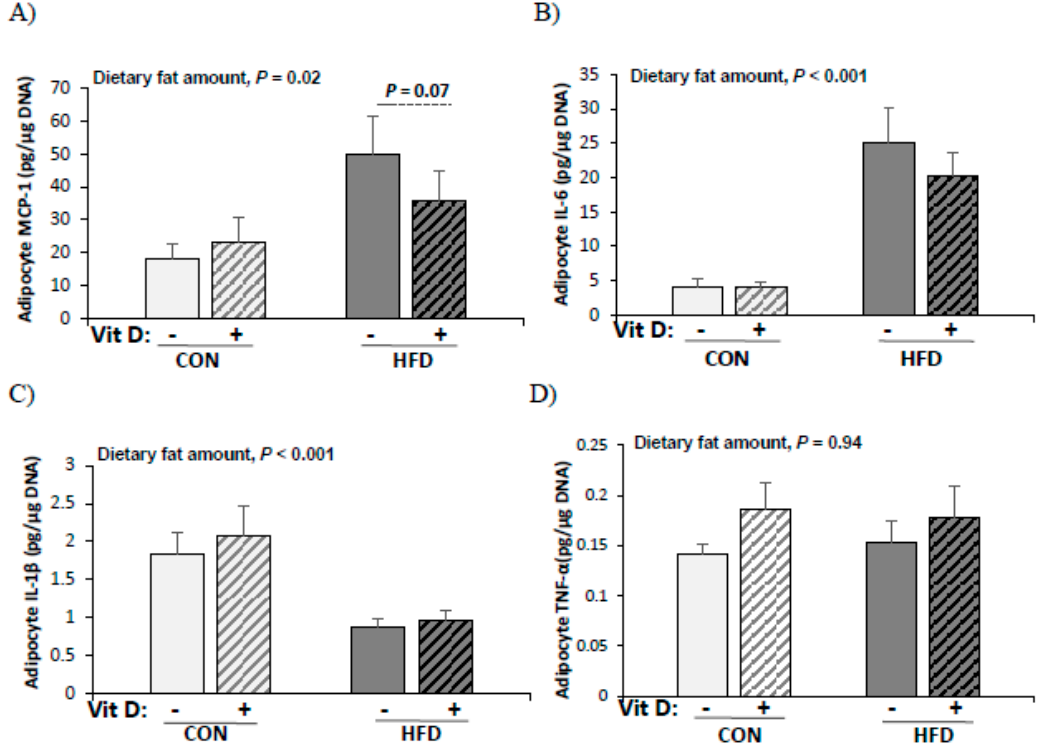
Figure 4. Production of pro-inflammatory cytokines by adipocytes from CON and HFD mice ( A ) MCP-1 (pg / µ g DNA), ( B ) IL-6 (pg / µ g DNA), ( C ) IL-1 β (pg / µ g DNA), and ( D ) TNF- α (pg / µ g DNA). Adipocytes were treated with vehicle (0.1% ethanol) or 1,25(OH) 2 D 3 (10 nM) for 24 h before being stimulated with LPS (0.1 µ g / mL) for another 24 h. Production of each cytokine level was normalized with total cellular DNA. Data are presented as mean ± SEM, n = 9~10 for each group. A paired t -test was used to determine the significant effects of in vitro 1,25(OH) 2 D 3 treatment and * indicates a significant difference ( p < 0.05). A student’s t test was used to determine the significant effect of dietary fat amount. CON: 10% kcal fat diet; HFD: 60% kcal fat diet.